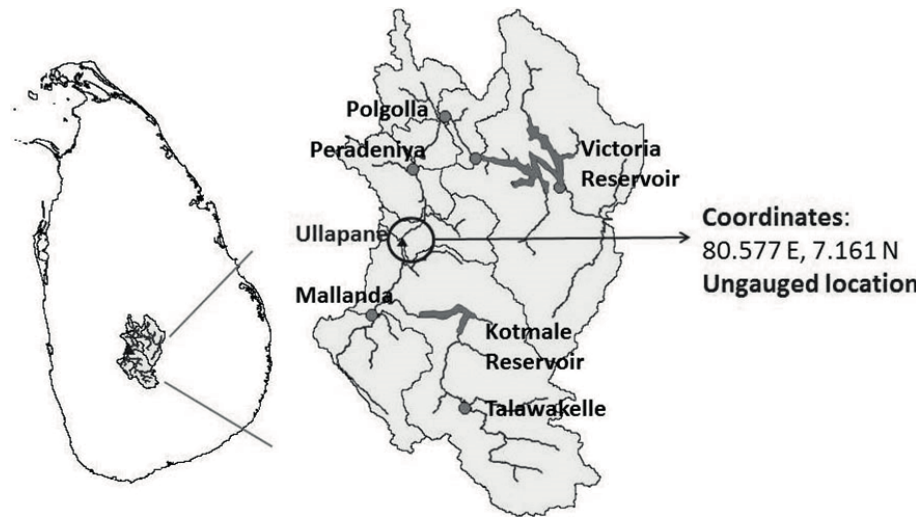
Fig. 2 Location of Peradeniya and Ullapane on River Mahaweli where EF is